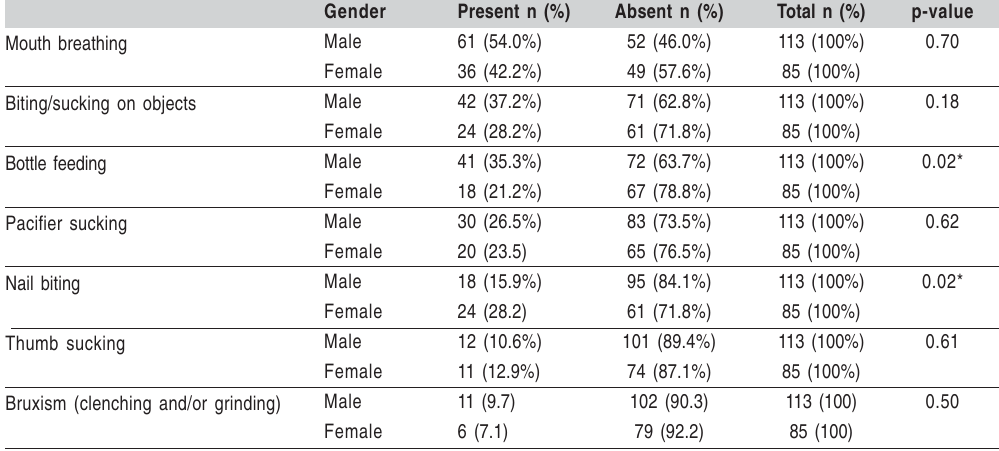
* Statistically significant (p <